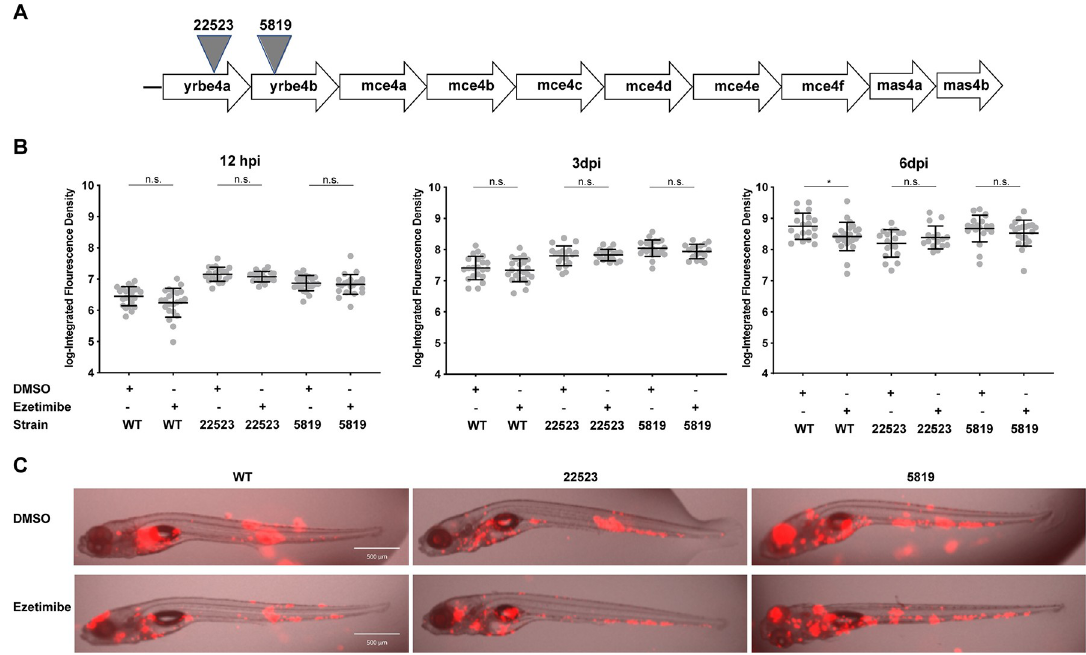
Fig 4. Mutations at the mce4 locus eliminate the effect of ezetimibe on infection burden. a . Schematic representation of mce4 locus showing location of transposon insertion mutants. b . Comparison of infection burden at 12hpi, 3dpi, and 6dpi in animals infected with wild-type, yrbe4a Tn22523 , or yrbe4b Tn5819 and then treated with vehicle alone (DMSO) or 1 μ M ezetimibe. Student’s t-test � p = 0.021. Representative of three independent experiments. c . Median animals from 6dpi comparison groups in (b). Bar = 500 μ m.